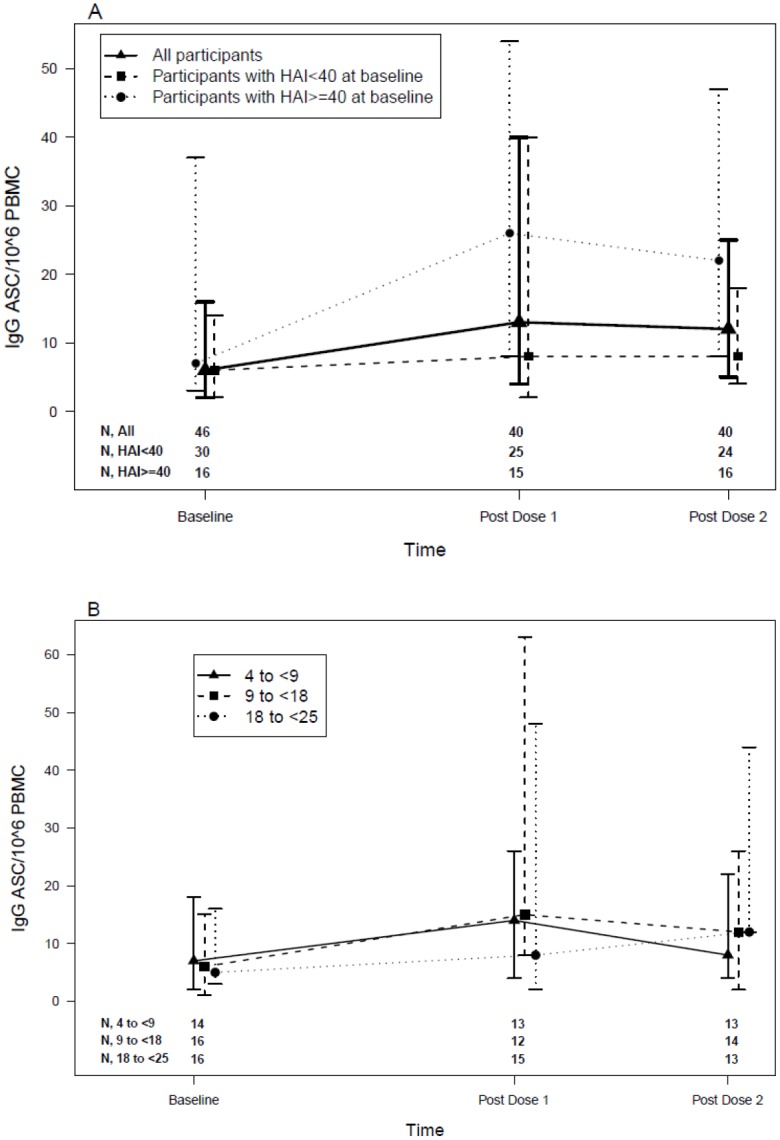
IgG ASC measured by ELISPOT (memory B-cells) at Baseline and after Vaccination.Data were derived from HIV-infected youth and children who received 2 doses of pH1N1 inactivated monovalent vaccine (30 μg/dose) approximately 3 weeks apart. Data represent medians and IQR of the IgG ASC/106 PBMCs at each timepoint. The number of subjects per group at each time point is listed on the graph. A presents the IgG responses for all subjects and also for the subjects divided by baseline pH1N1 HAI immune serostatus (HAI titer <1:40 versus ≥1:40). After the first immunization there was a significant increase in IgG ASC (p = 0.048). There were no statistical differences in IgG ASC within each HAI immune serostatus group between baseline and the two vaccinations, but subjects with baseline HAI ≥1:40 titers had significantly higher IgG ASC after vaccination than those with titers <1:40 (p = 0.03). B depicts the median IgG ASC by age group. There were no statistical differences in IgG ASC within each age group between baseline and the two vaccinations.